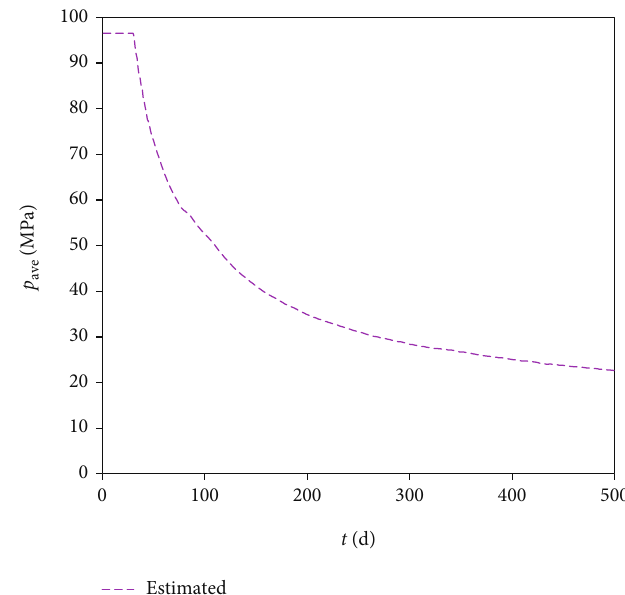
Figure 21: The estimated pro fi le of average reservoir pressure for the gas well H-58.